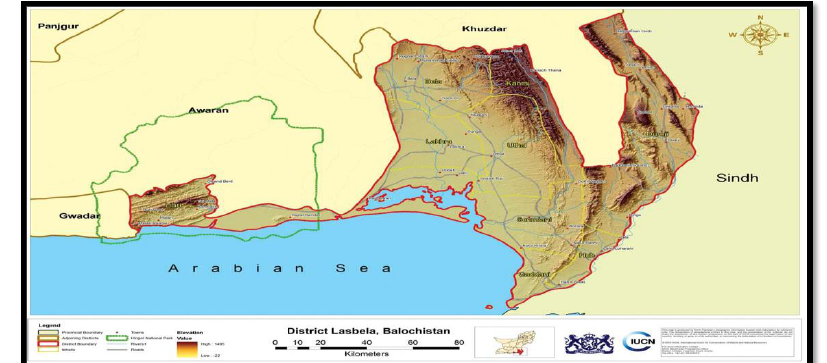
Fig. 1: : District Development Profile, 2011, & P&D Department Balochistan and